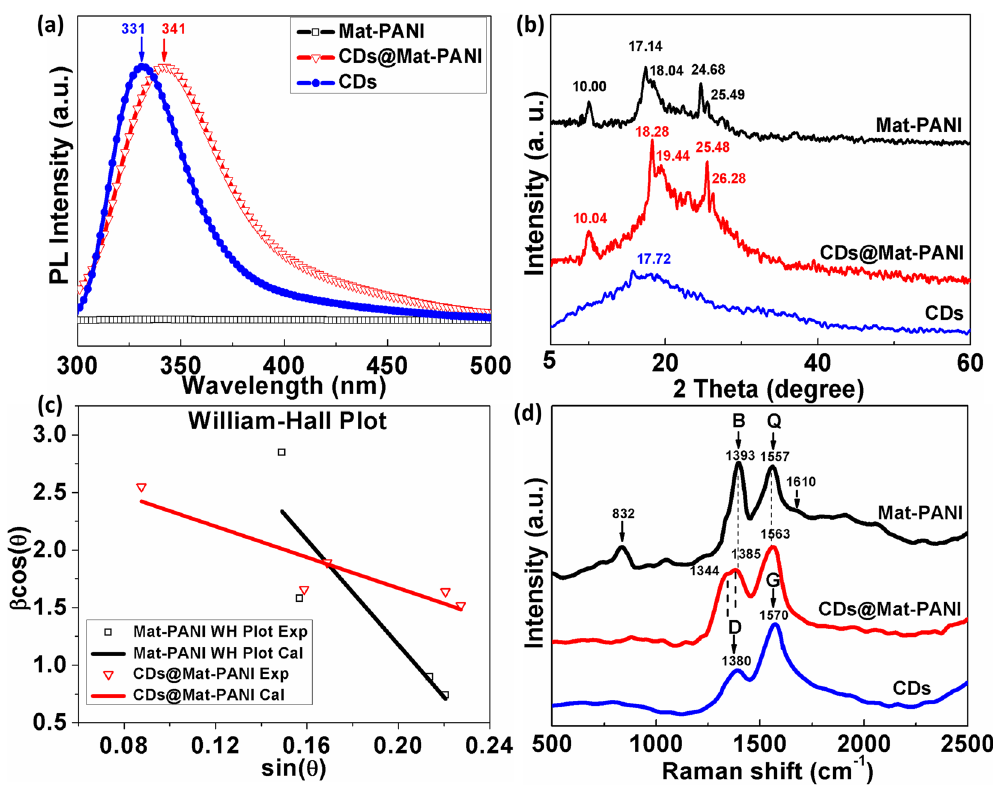
Figure 3. ( a ) PL spectra, ( b ) XRD patterns, ( c ) William-Hall plots of Mat-PANI and CDs@Mat-PANI, and ( d ) Raman spectra of Mat-PANI, CDs@Mat-PANI, and